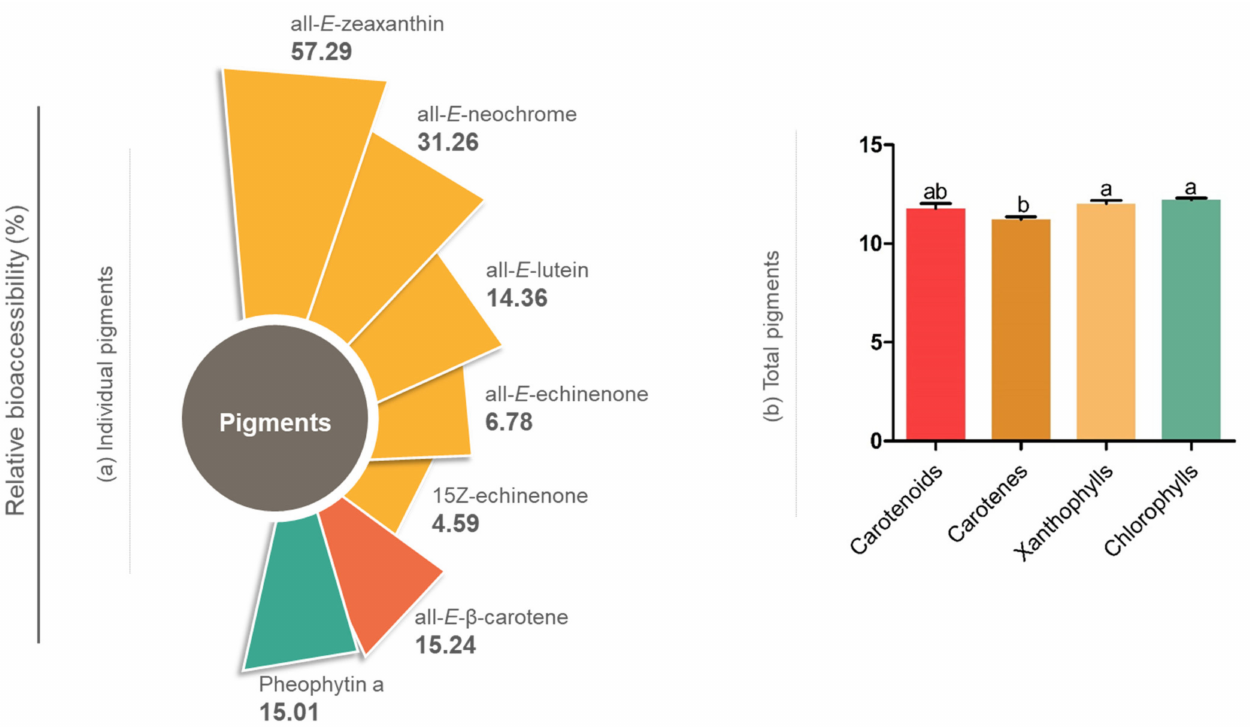
Figure 1. Relative bioaccessibility of individual ( a ) and total pigments ( b ) from C. calcitrans . Different letters in ( b ) indicate a significant difference using Tukey’s test ( p <